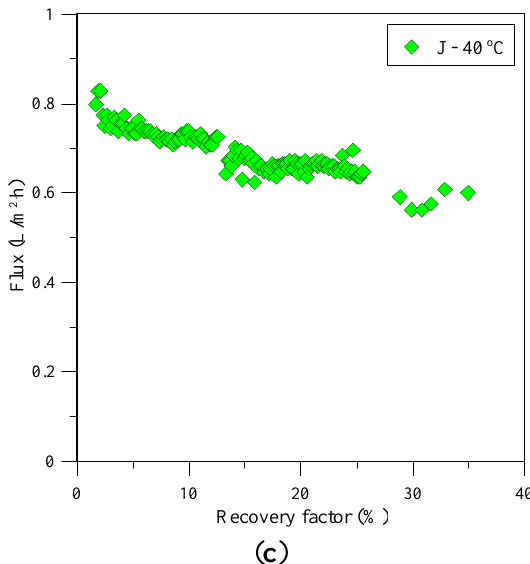
Figure 2. Discrete flux and recovery factors obtained at various thermal conditions for PP and PVDF membranes. ( a ) PP lab made modules ( b ) Lab made PVDF based modules ( c ) Commercial PP modules. The lines show the theoretical flux.